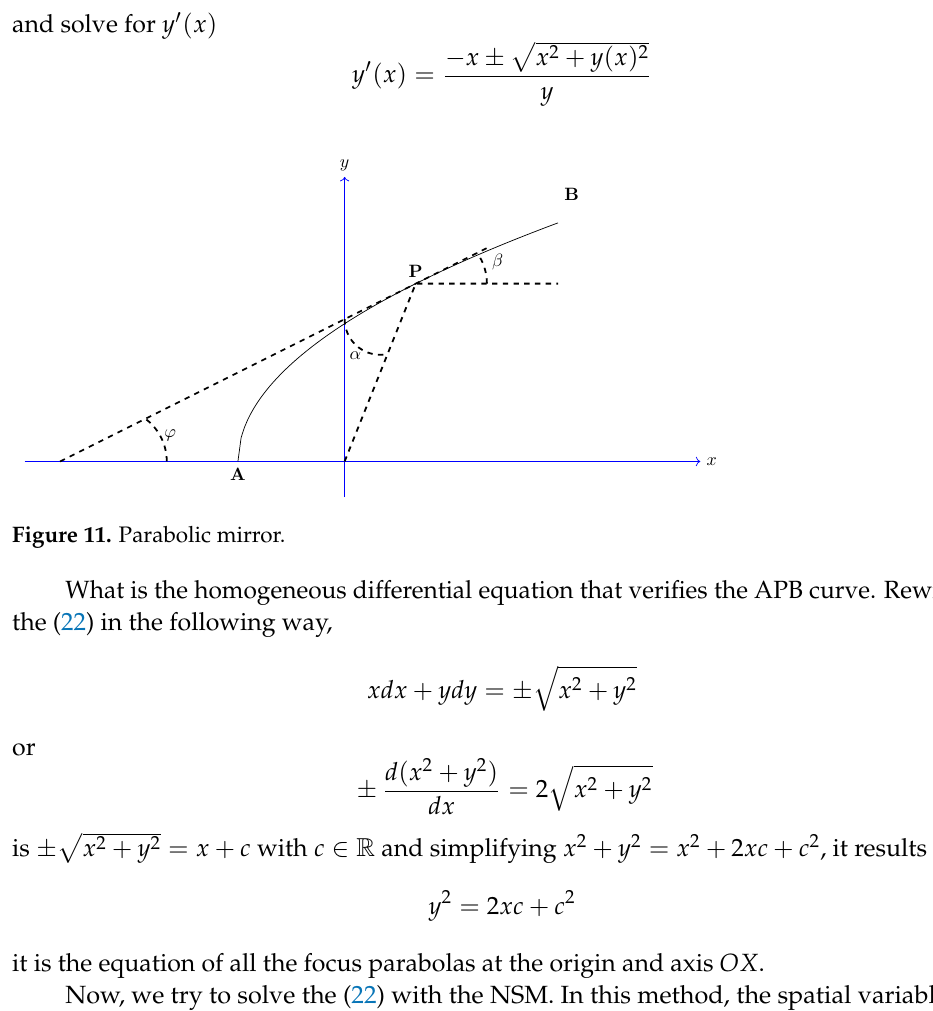
Figure 9. Zoom of the figure 4